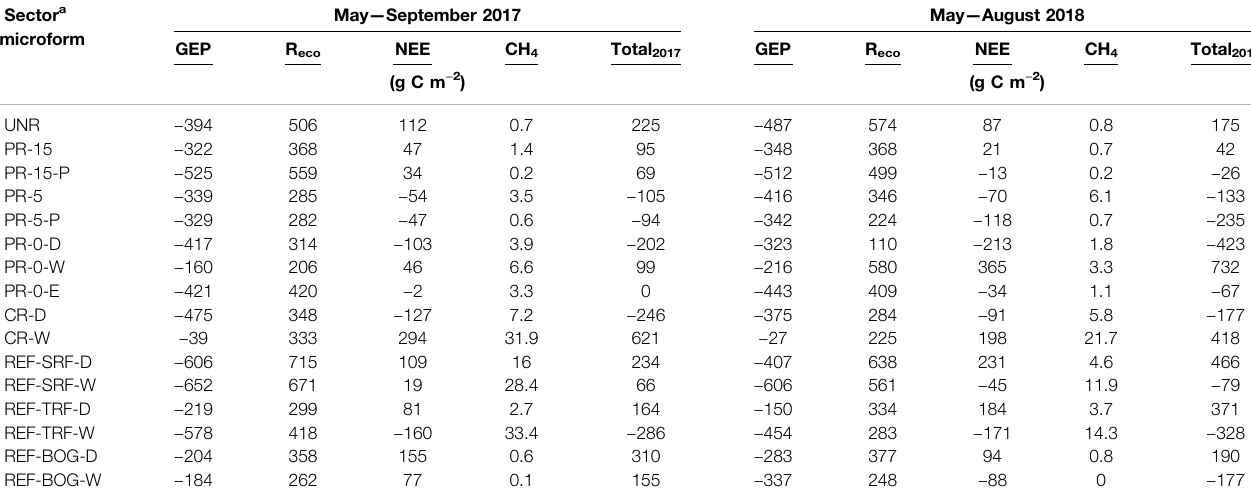
TABLE 7 | Cumulative seasonal carbon fl uxes of methane (CH 4 ), and net ecosystem exchange (NEE) as a product of gross ecosystem production (GEP) and ecosystem respiration (R eco ), for all monitoring sectors a in 2017 and 2018. Both seasonal calculations were done for a time period of 107 days (17.5.2017 – 31.8.2017 and 22.5.2018 – 5.9.2018).